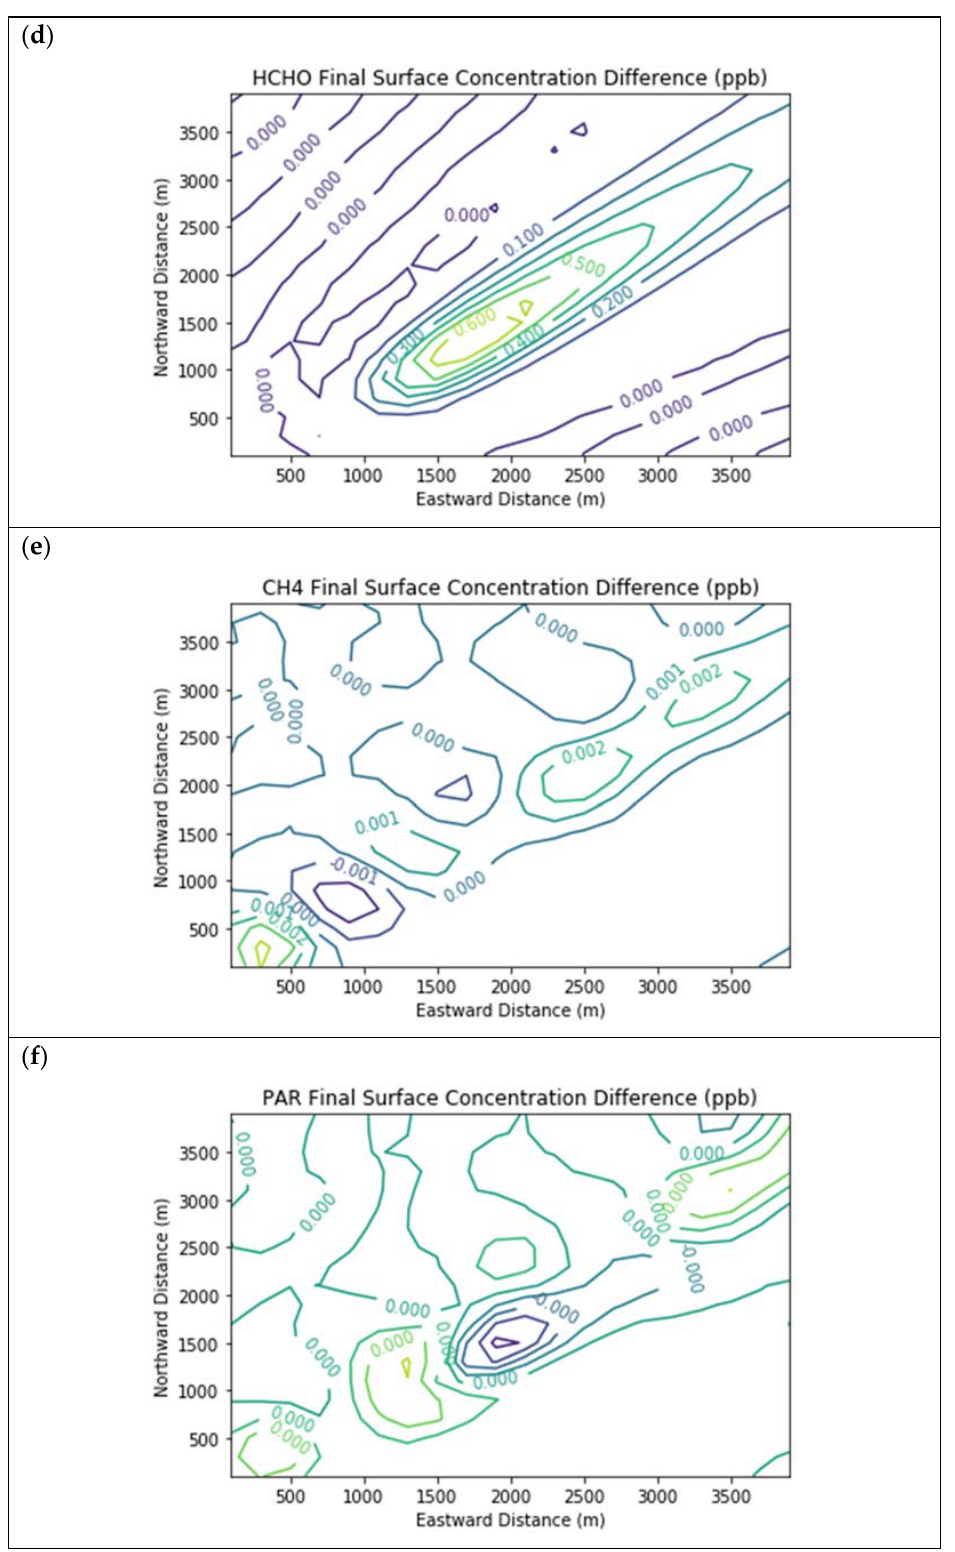
Figure 4. Near Source: Combustion Only ― Baseline. Difference plots of ( a ) NO, ( b ) NO 2 , ( c ) O 3 , ( d ) HCHO, ( e ) CH 4 , and ( f ) PAR between the Combustion Only and Baseline scenarios at the end of the 3-h simulation for the 4 km × 4 km domain.